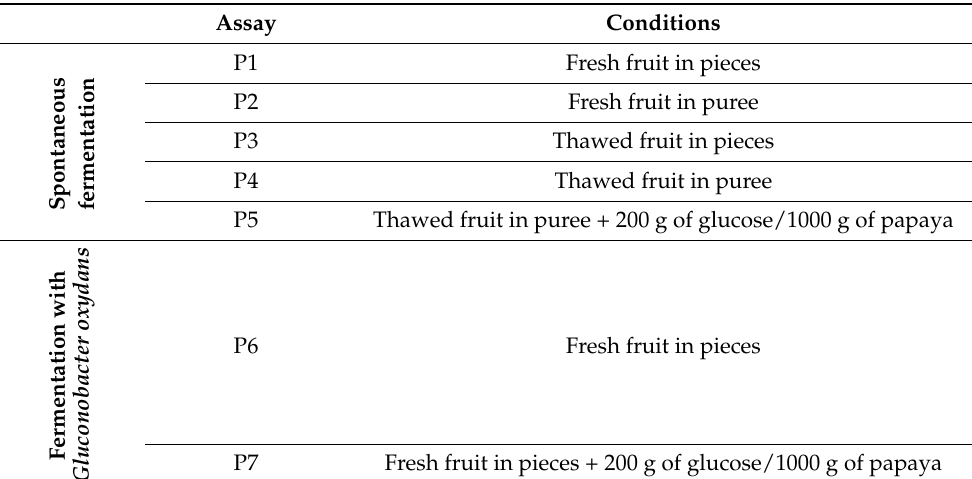
Table 1. Conditions of the assays carried out in the different types of